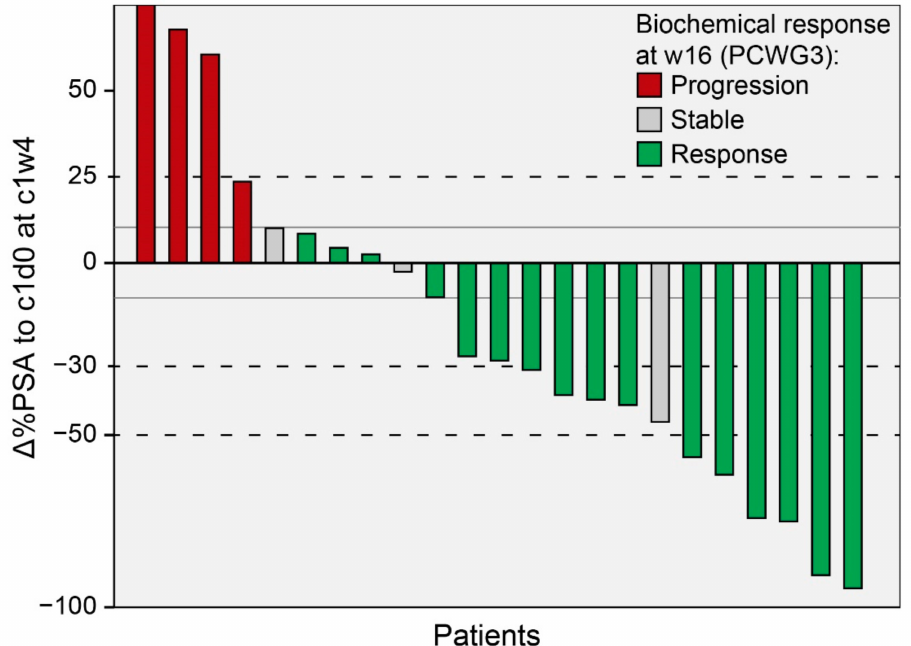
Figure 3. Waterfall plot of percental PSA change ( ∆ %PSA) four weeks (c1w4) after the first admin- istration of PSMA-RLT (relative to the baseline), with bar coloring according to the biochemical response at restaging after 16 weeks (w16) categorized by PCWG3 criteria. Response: PSA decrease ≥ 50%, Stable: PSA decrease ≤ 50% or PSA increase ≤ 25% and Progression: PSA increase ≥ 25%. Dashed lines represent a priori defined thresholds for responses classified at c1w4. Grey, nonbroken lines represent thresholds with the highest discriminatory power at c1w4 ( ± 10%), calculated by a retrospective ROC